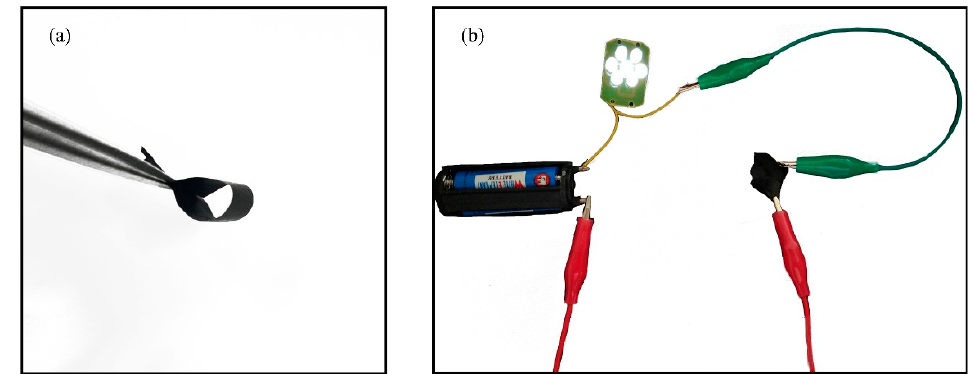
Figure 18. ( a ) Flexibility demonstration of fabricated the PAN/PSA carbonized membrane; ( b ) Performance demonstration using a light-emitting diode wired to PAN/PSA carbonized membrane. The spinning voltage is 20 kV and the receiving distance is 200